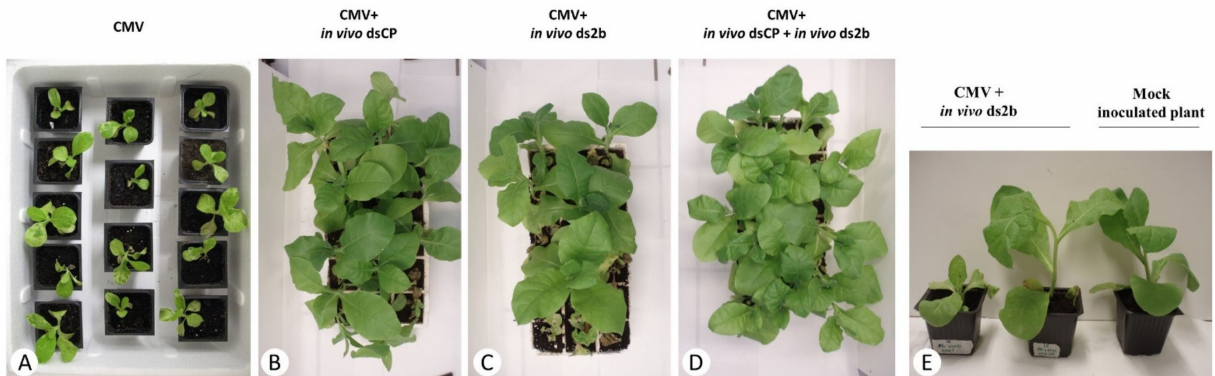
Figure 3. In vivo produced dsRNA molecules confer resistance to tobacco against CMV. Response of tobacco plants to the application of CMV jointly with in vivo produced dsRNA derived from the cognate virus. The tobacco plants were inoculated with: ( A ) CMV, ( B ) CMV jointly with in vivo dsCP, ( C ) CMV jointly with in vivo ds2b, ( D ) CMV jointly with in vivo dsCP and in vivo ds2b, ( E ) CMV jointly with in vivo ds2b in comparison with a mock (water) inoculated plant. Plants were photographed at 21